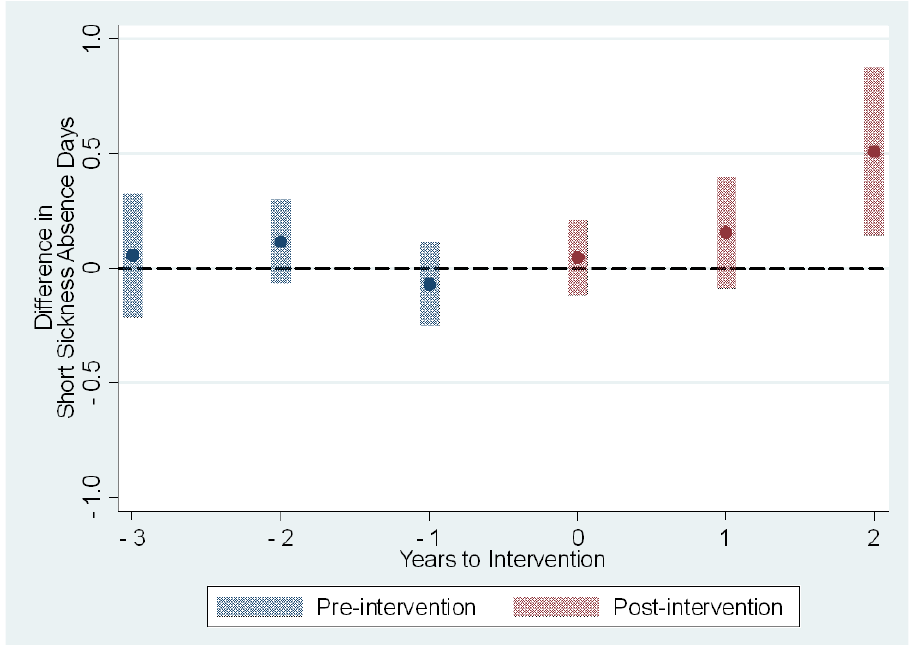
Figure 2. The estimated dynamic average treatment effects of the use of the participatory scheduling tool on sickness absence episodes from all sickness absences. Event study estimates with 95% con- fidence intervals depict difference in outcome measure between intervention and control groups relative to timing of the intervention. Year 0 is the first full year of the intervention.